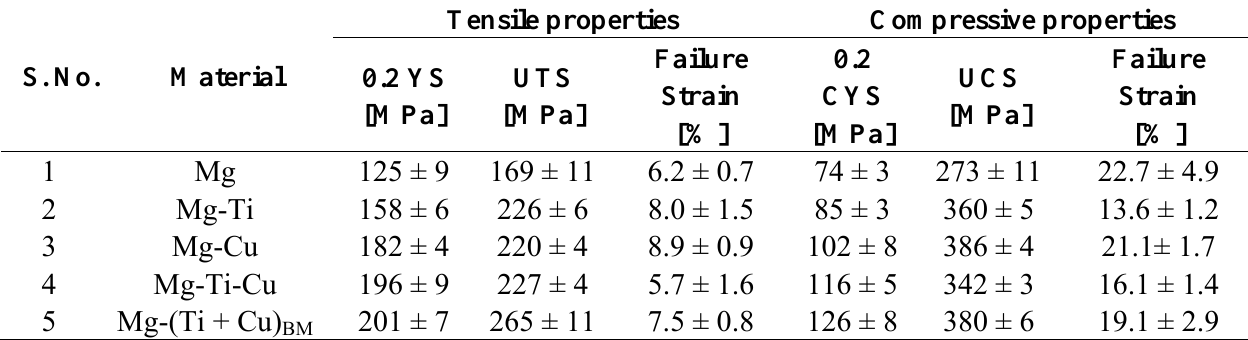
Table 4. Results of room temperature tensile and compression tests.